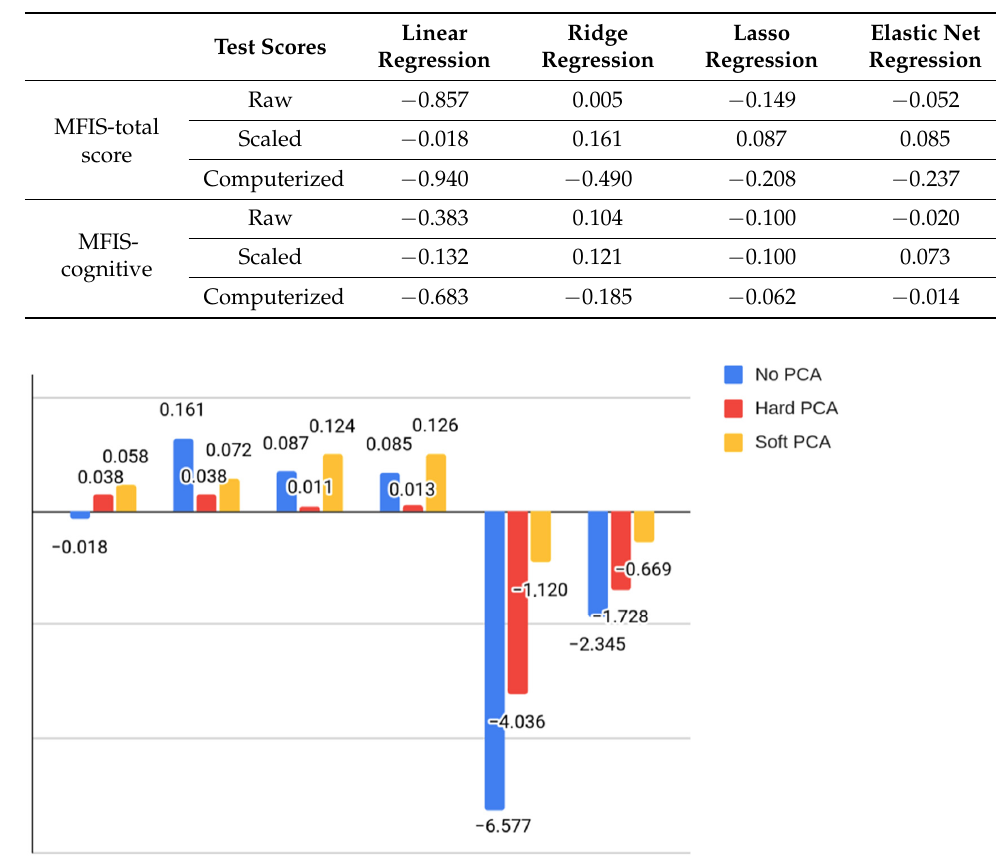
Table 3. R 2 scores of the regression models for predicting Modified Fatigue Impact Scale (MFIS) score for each subset of neuropsychological test results.